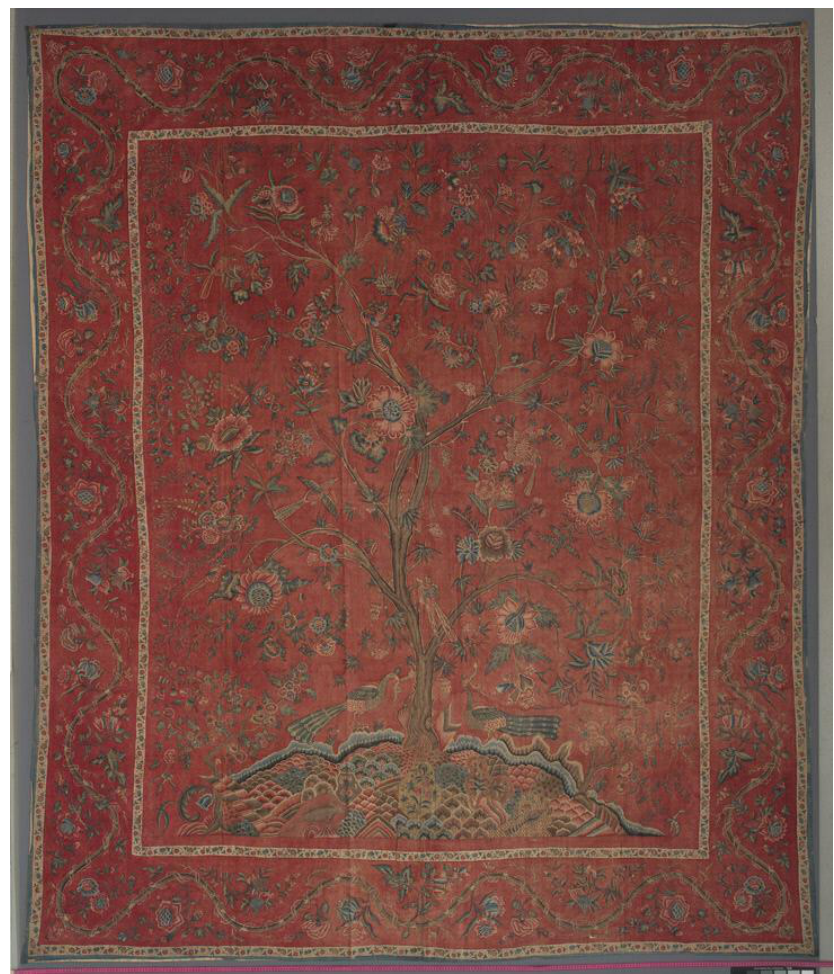
Figure 11. Palampore (textile panel), Chintz: cotton tabby, painted, mordant-dyed, resist-dyed, Figure 11 overpainted, made in coastal southeast India, for the Western, possibly Dutch, market, c. 1750. Gift of Louise Hawley Stone Charitable Trust, Royal Ontario Museum (2011.27.1). Courtesy of the Royal Ontario Museum, ©